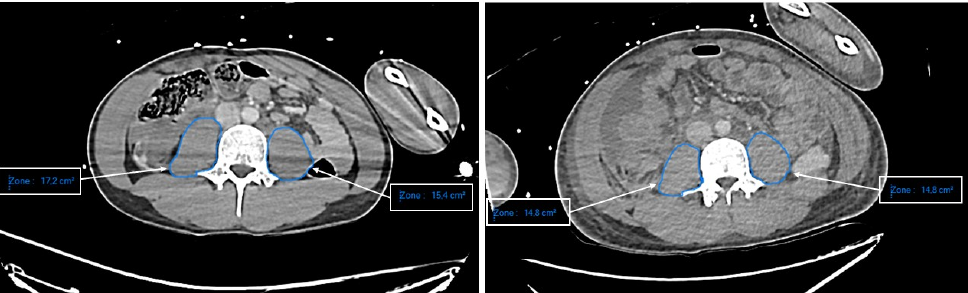
Figure 1. Example of muscle psoas cross-sectional area (CSA) measurement on the first (day 1) and the second (day 4) abdominal CT scan. Zone: Muscle psoas cross-sectional area calculated at the L4 level. Mean CSA at day 0: 1630 mm 2 ; mean CSA at day 4: 1480 mm 2 . Δ CSA = 375 mm 2 /day; % Δ CSA = 5.8% per day.